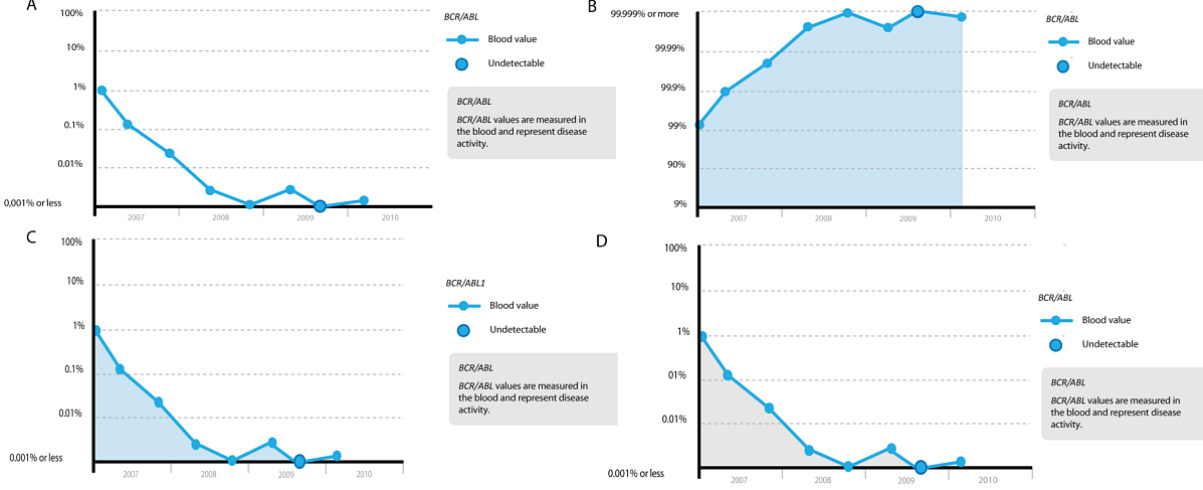
Figure 2. Four examples of graphs depicting BCR-ABL1 values. Graphs B, C, and D have a colored area under the curve, in contrast to graph A. Furthermore, the percentages on the y-axis differ: graphs A, C, and D have percentages from 100 to ≤ 0.001, representing the number of BCR-ABL1 transcripts. Graph B has a positive approach with percentages from 9 to ≥ 99.999, representing the amount of healthy